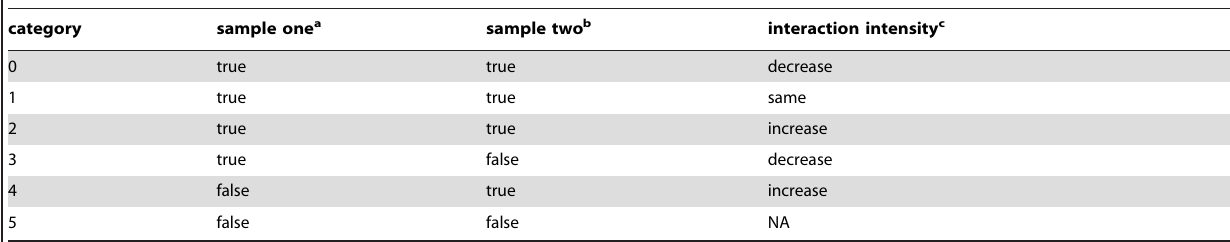
Table 1. Category of